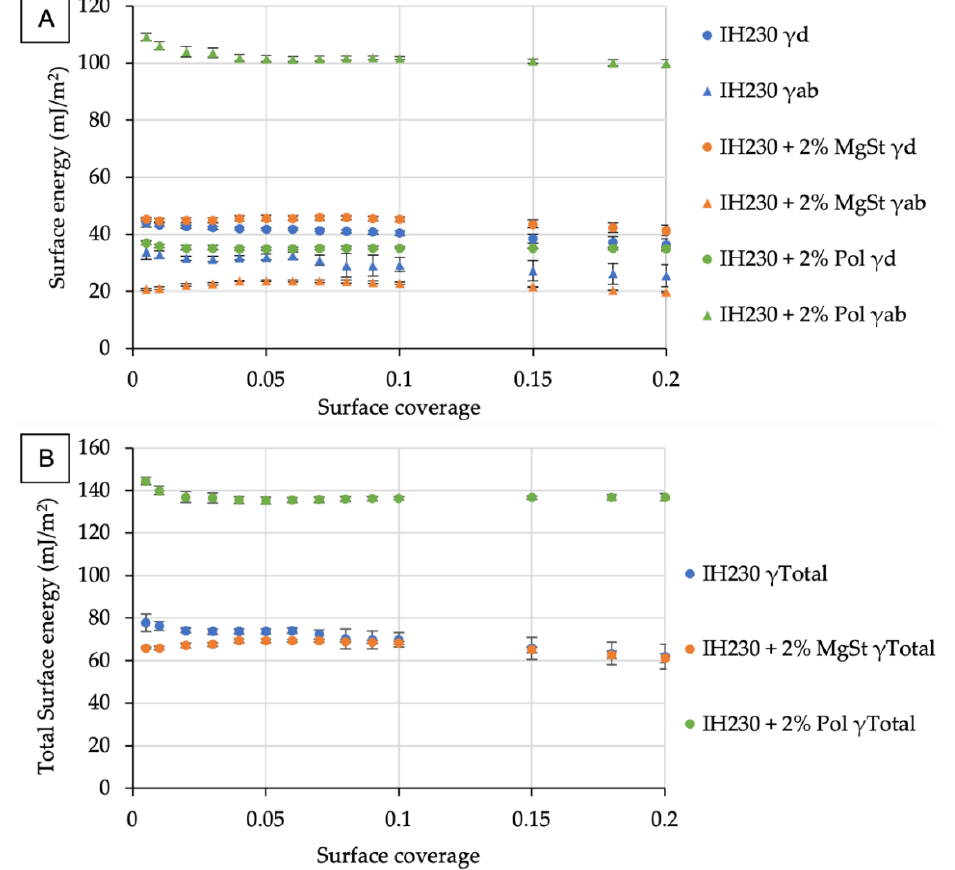
Figure 2. Surface energy distributions of lactose carriers with and without additives. ( A ) depicts the changes in the surface energy ( γ ) composition, i.e., the suffix “d” indicates the dispersive part and suffix “ab” the acid–base or polar part of the respective surface energy. ( B ) shows the resulting total surface energies for all samples. n = 3, error bars denote standard deviation.